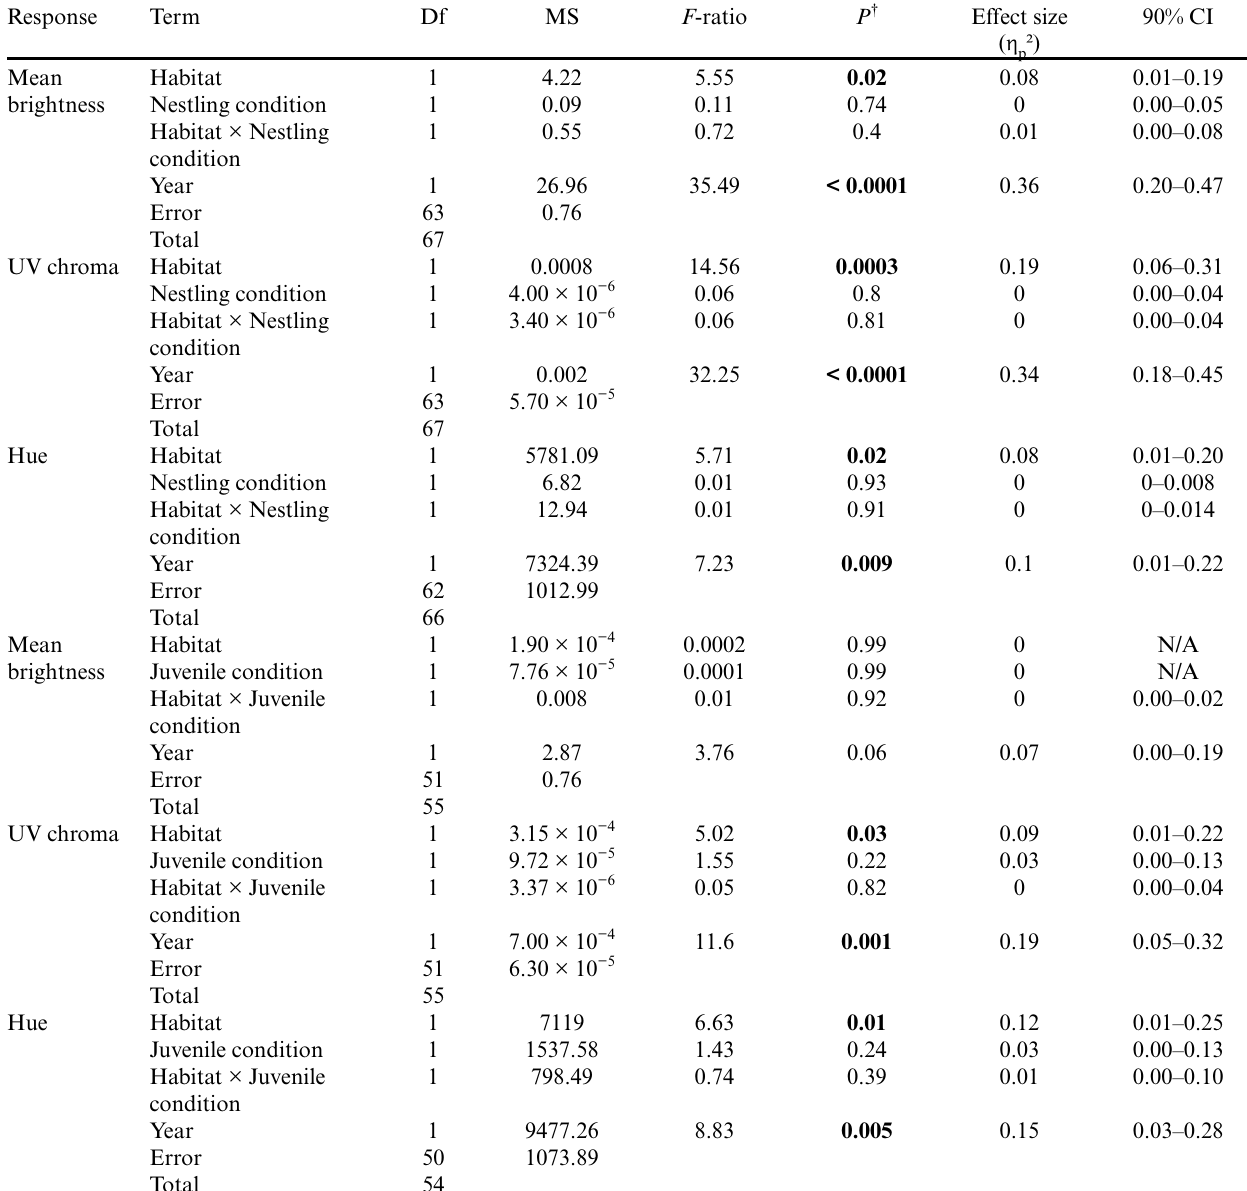
Table 2. Relationships between color variables, habitat, and body condition of nestling and juvenile Florida Scrub-Jay individuals from a suburban and a wildland